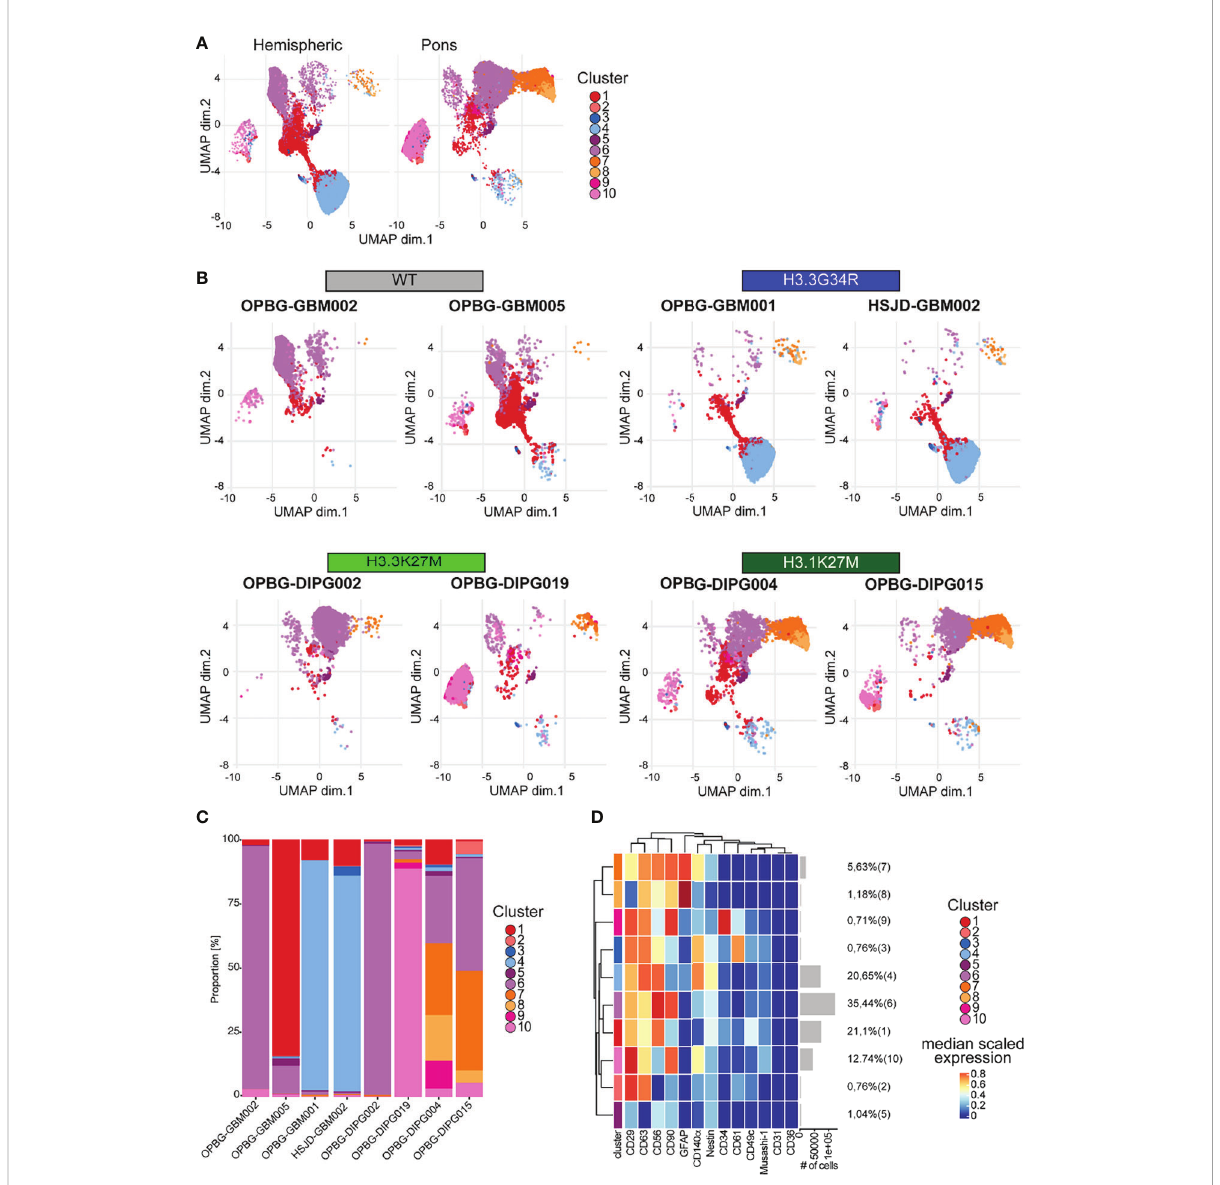
FIGURE 7 UMAP analysis. (A) UMAP plots of the hemispheric and pons cell lines colored according to the identi fi ed clusters. (B) UMAP plots for each of the analyzed cell lines, colored according to the identi fi ed cluster. (C) Bar plots representing the abundance of each of the clusters identi fi ed in each cell lines. (D) Heatmap summarizing the antigenic pro fi le of each of the identi fi ed